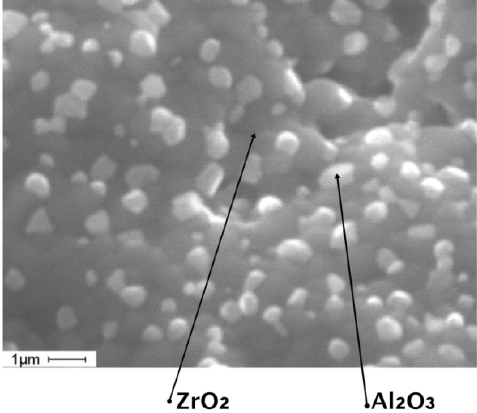
Figure 10. Image of the structure of ZrO 2 (Y 2 O 3 ) ‐ 20%Al 2 O 3 ceramics obtained after high ‐ temperature sintering.